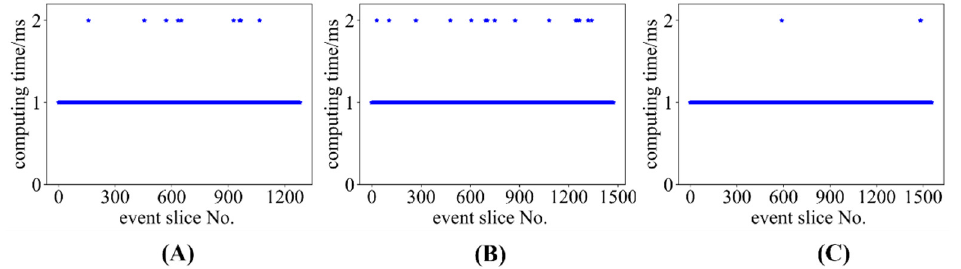
Figure 9. Computing time of SpiNNaker at different rotating speeds. ( A ) is computing time at 900 rpm; ( B ) is computing time at 1600 rpm; ( C ) is computing time at 2500 rpm. The computing time is basically kept at 1 ms at all speeds, except for some outliers of 2 ms .